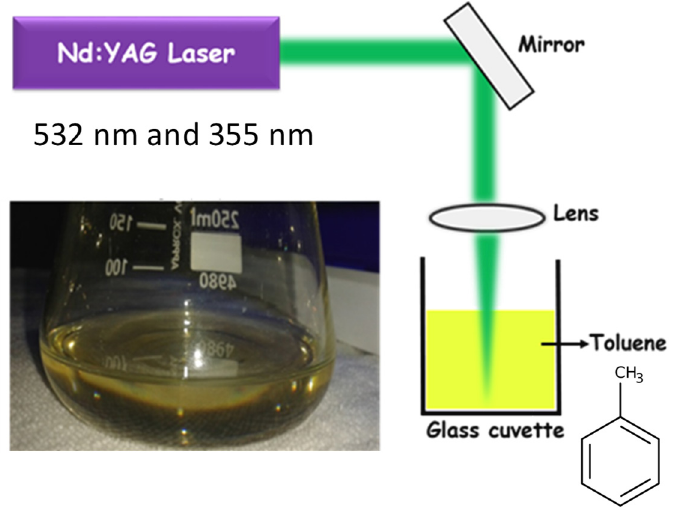
Figure 1. Experimental layout of production of GQD via laser irradiation in toluene and the yellowish GQD solution just after irradiataion.